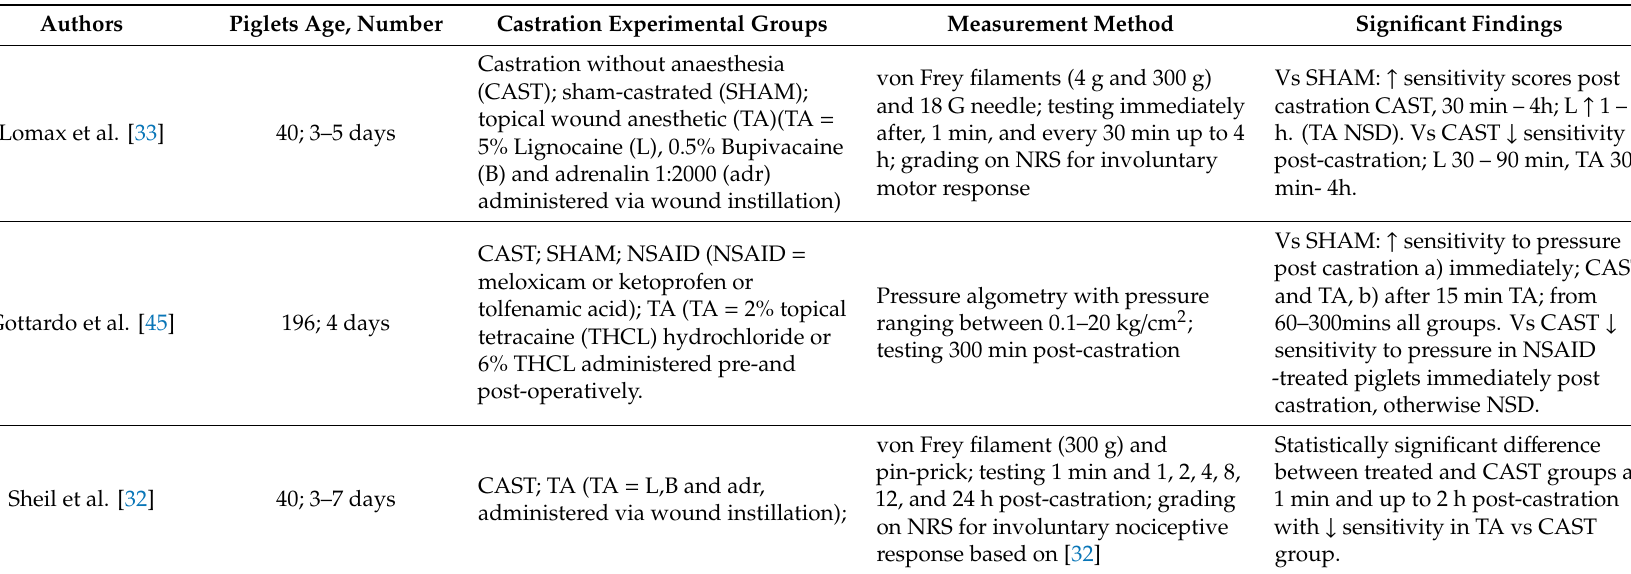
Table 6. Summary of studies assessing wound sensitivity after castration in neonatal piglets. (Arrows indicate statistical significance (p < 0.05). NSD = No significant di ff erence of